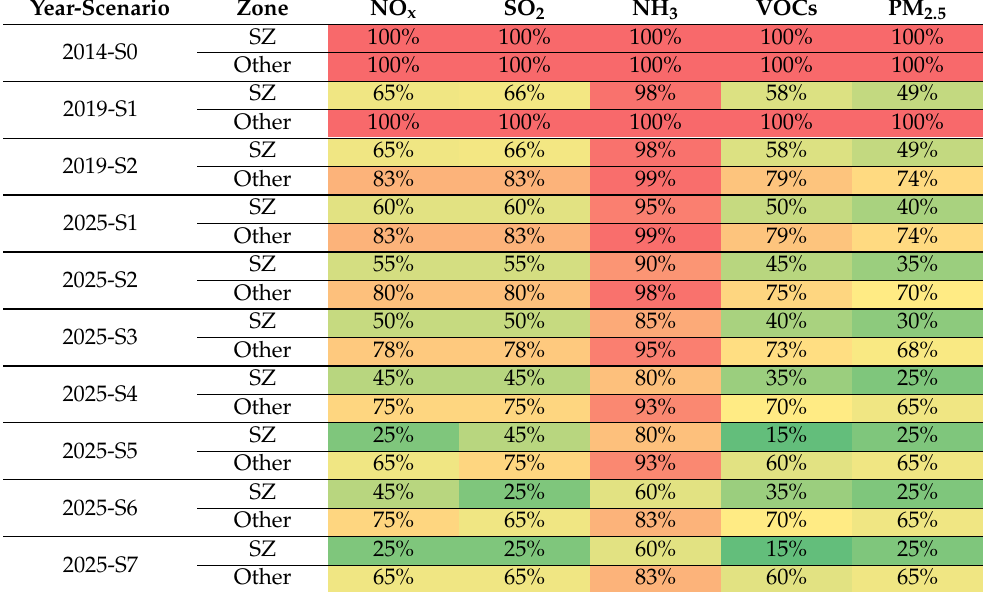
Table 5. Emission ratio in each scenario.